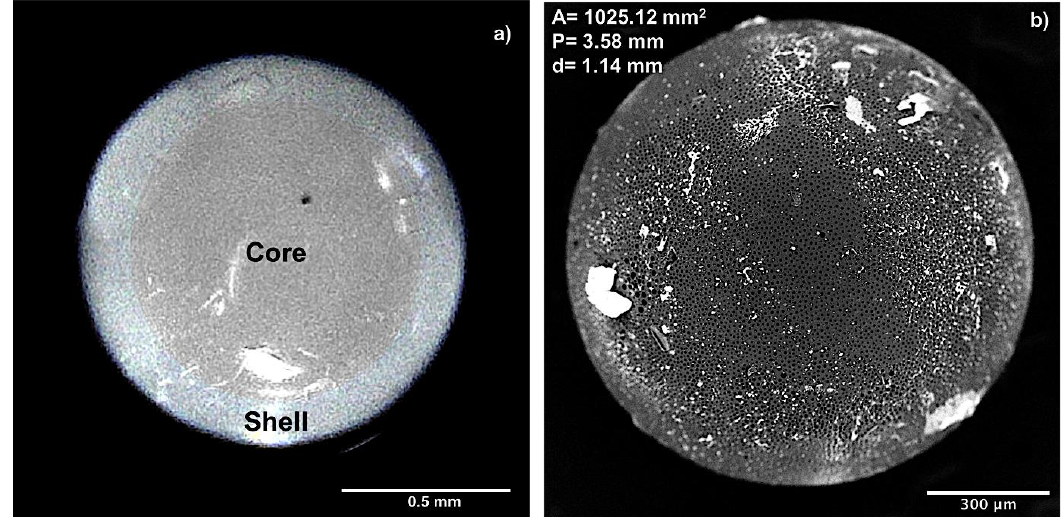
Figure 1. (a) Optical microscopy analysis of poly(methyl-methacrylate) (PMMA) capsule; (b) scanning Figure 1. ( a ) Optical microscopy analysis of poly(methyl-methacrylate) (PMMA) capsule; ( b ) scanning electron microscopy (SEM) image of PMMA capsules. electron microscopy (SEM) image of PMMA capsules.